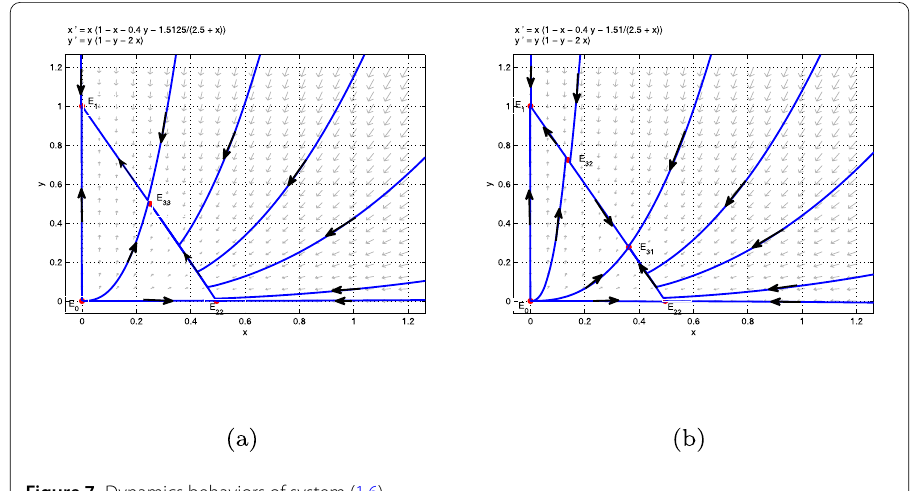
Figure 7 Dynamics behaviors of system